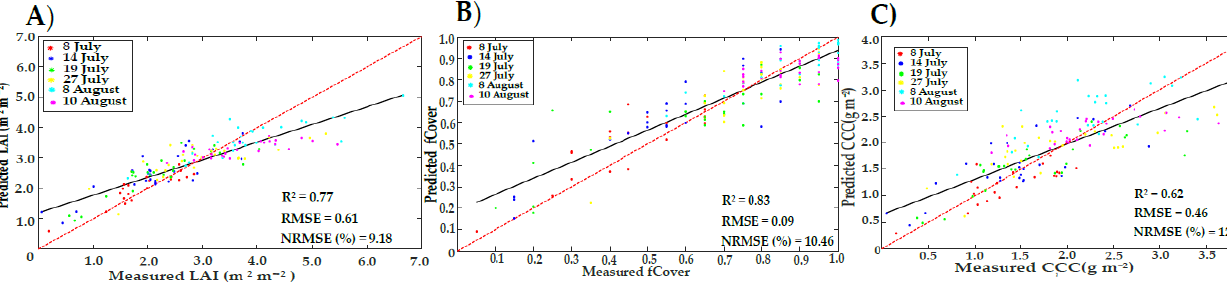
Figure 5. Scatterplots of LAI ( A ), fCover ( B ), and CCC ( C ) obtained from LUTreg using all data (156 samples); with trend lines for linear fitting (black) and 1:1 line (dashed